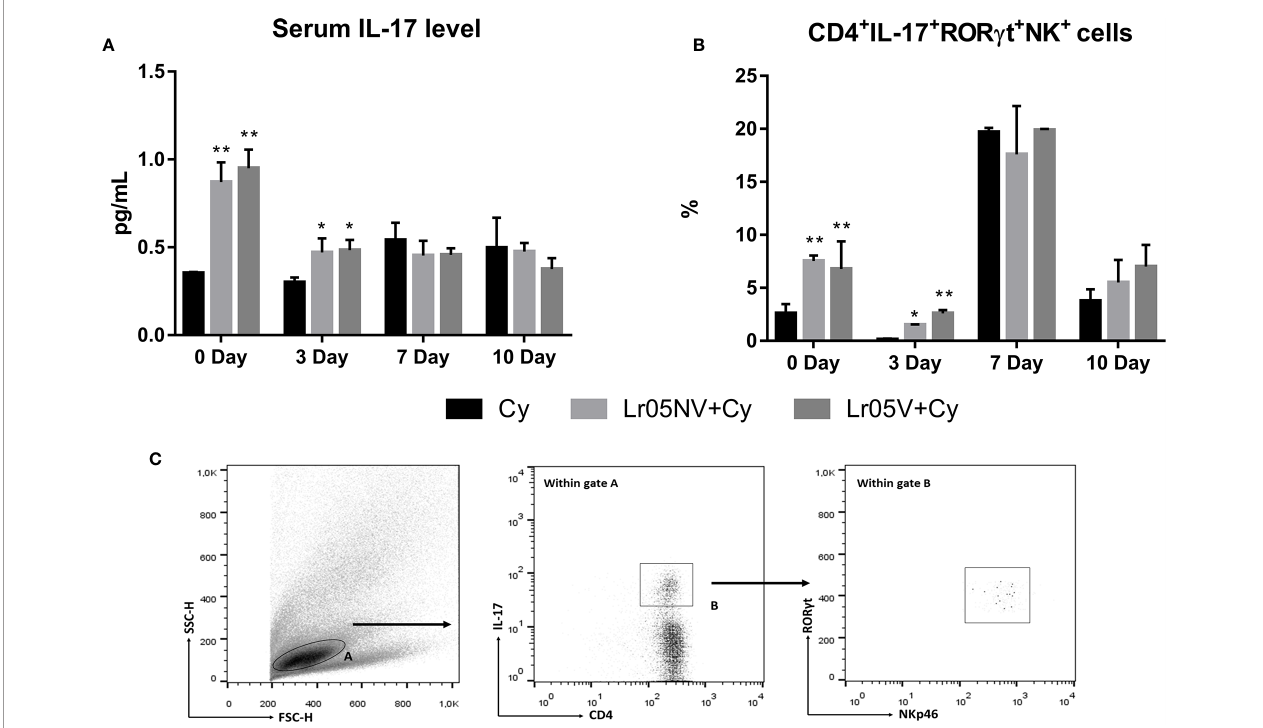
FIGURE 9 | Serum Il-17A and group 3 innate lymphoid cells in the intestinal lamina propria. 6-week-old Swiss mice were fed with 10 8 cells/mouse/day of viable or non-viable Lactobacillus rhamnosus CRL1505 (Lr05V+Cy or Lr05NV+Cy groups) for 5 consecutive days before injection of Cy. The treated groups and the untreated control mice (Cy group) received one dose of 150 mg/kg Cy intraperitoneally. Serum IL-17A level (A) and percentage of group 3 innate lymphoid cells in the intestinal lamina propria (B) were performed on day 0, before Cy administration, and days 3, 7 and 10 post-Cy administration. The results come from two independent experiments. Six animals per group each time were used in the experiments. Results are expressed as mean ± SD. **,* Signi fi cant differences from the Cy group should be as follows (p<0.002 or p<0.05 respectively). (C) Gating strategy to study CD4 + IL-17 + ROR g t + NK + cells in the intestinal lamina